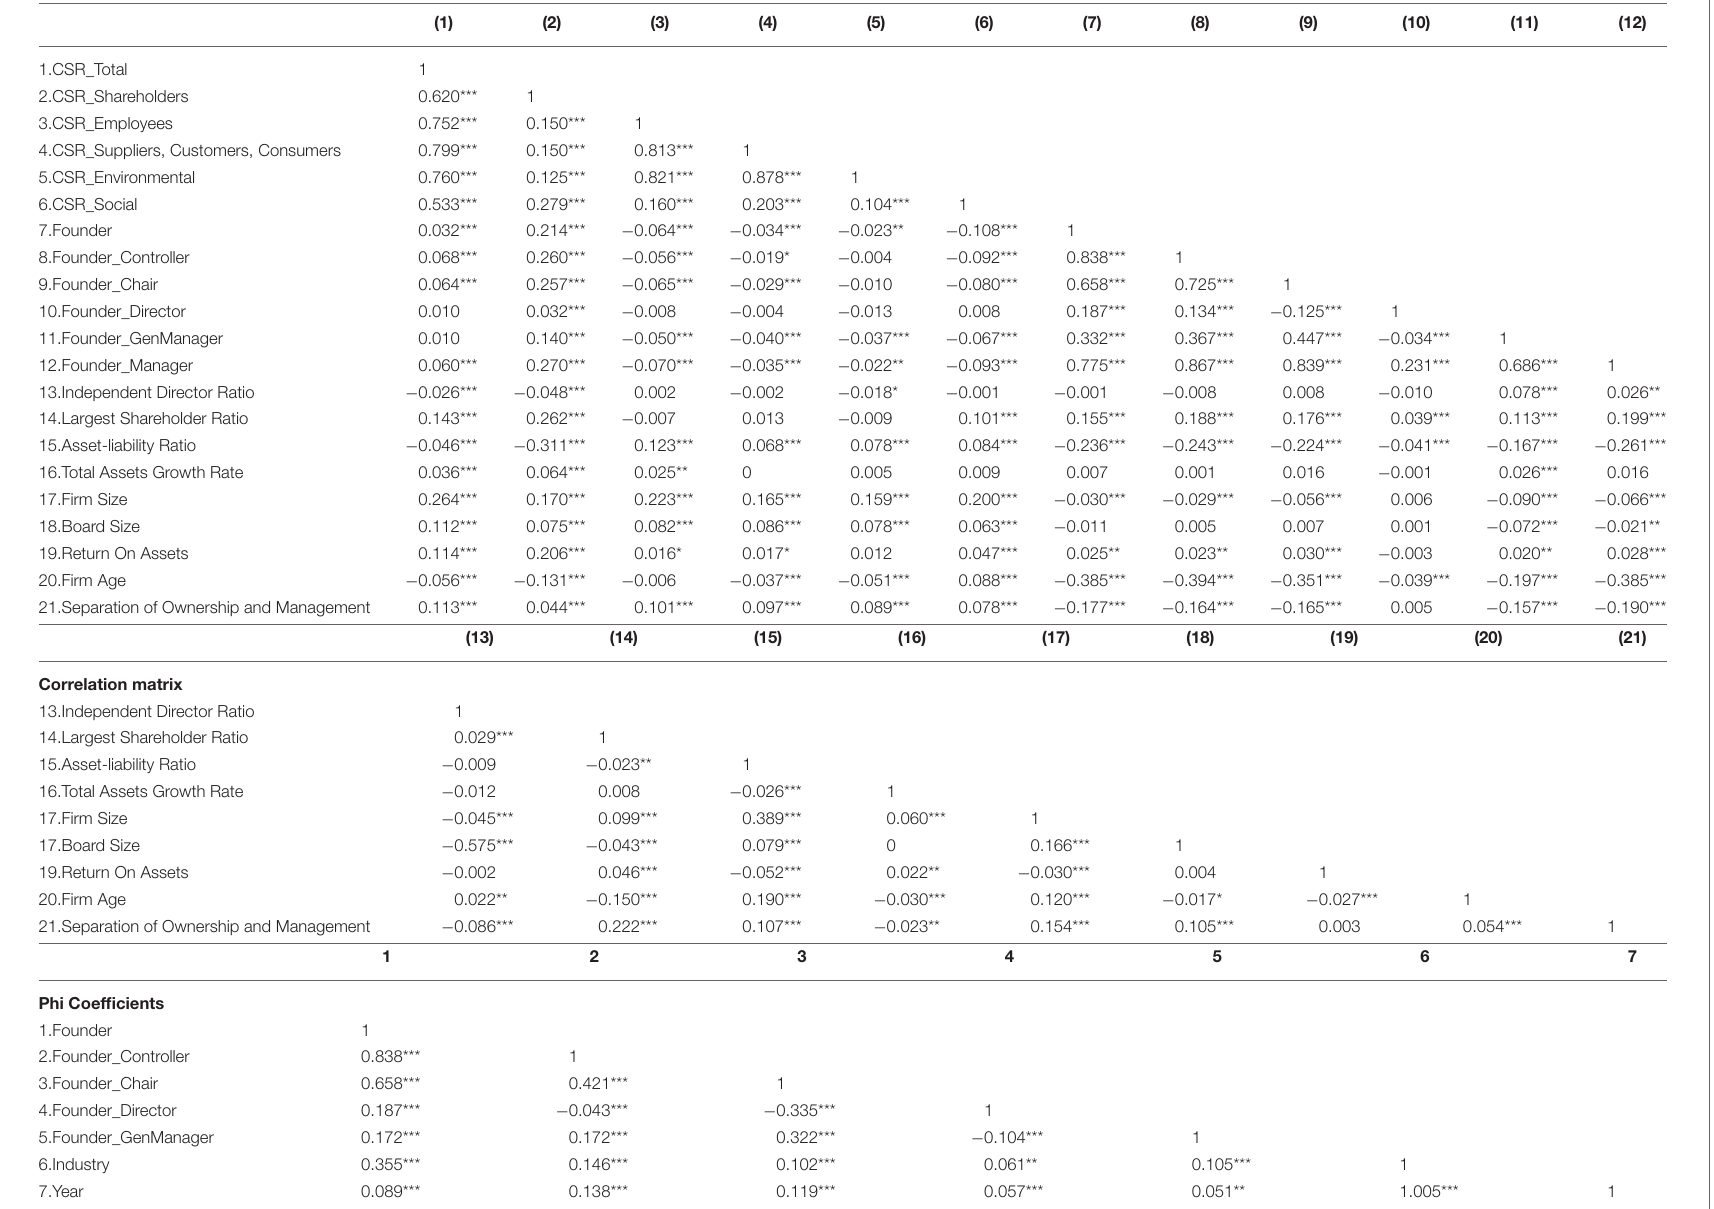
TABLE 5 | Correlation